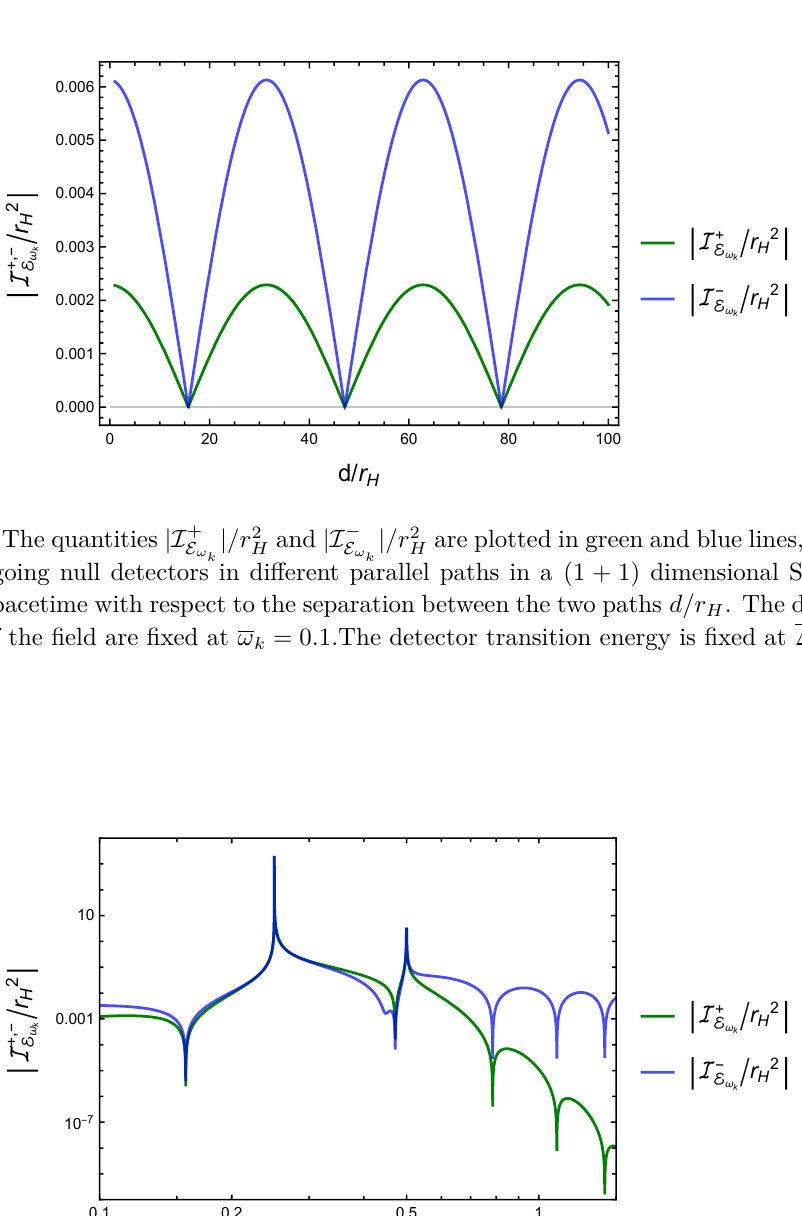
Figure 27 . The quantities |I + for two outgoing null detectors in different parallel paths in a (1 + 1) dimensional Schwarzschild black hole spacetime with respect to the separation between the two paths d/r frequency of the field are fixed at d/r It should be mentioned that these plots are expressed in Log − Log manner for the convenience of